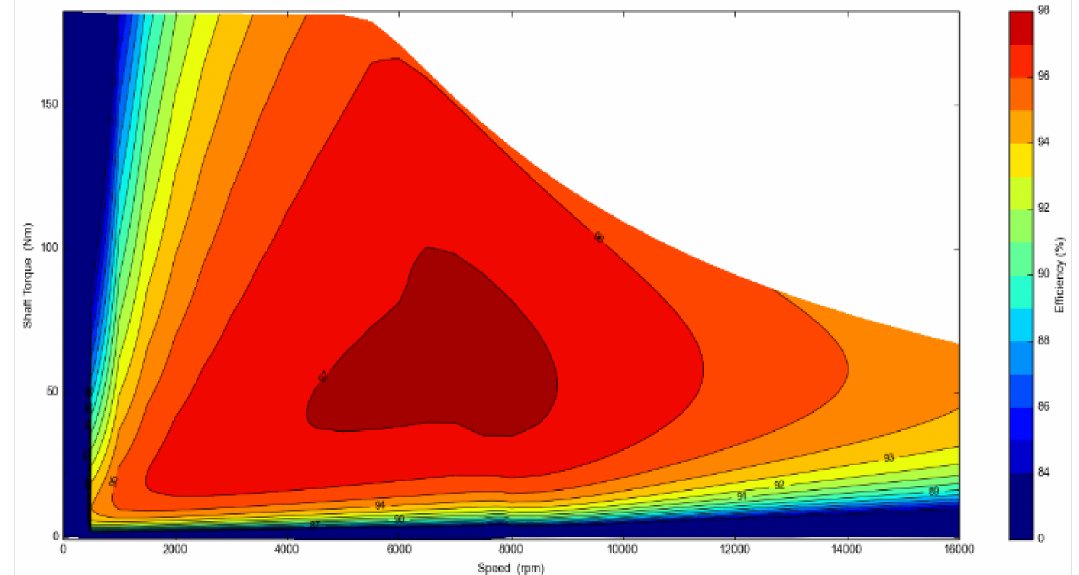
Figure 9. Efficiency map of double-V-shaped